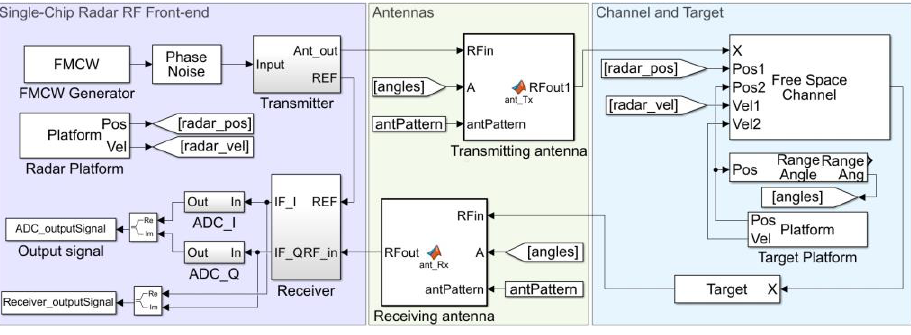
Fig. 6. Second-level model in Simulink.